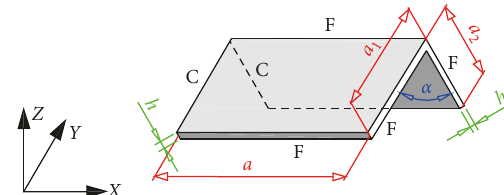
Figure 9: Geometry and boundary conditions of isotropic folded Table 4: Dimensionless frequencies ω ∗ � ω a ( ρ (1- ] 2 )/ E ) 1/2 of isotropic cantilever folded plate clamped along the edge X � 0 for crank angle